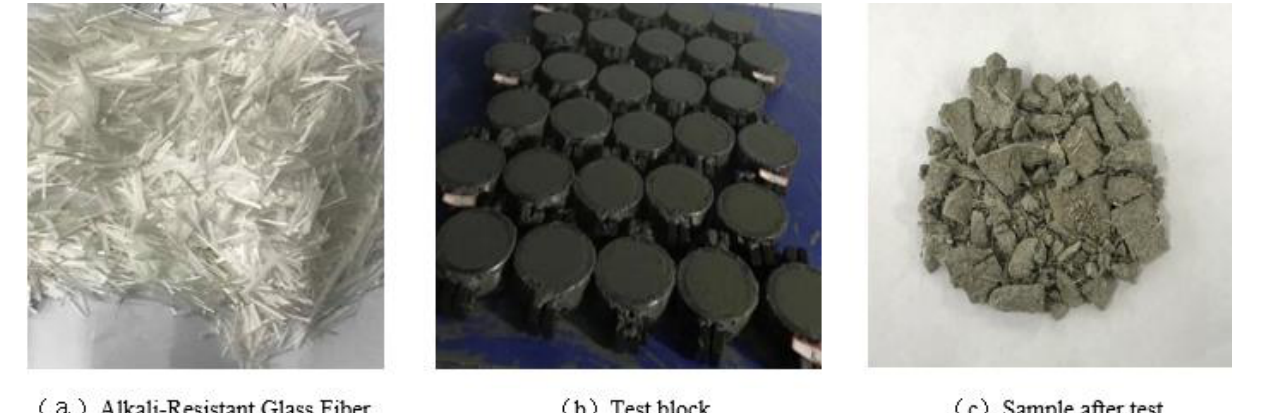
Figure 1. Photos of the materials, samples and experiments.